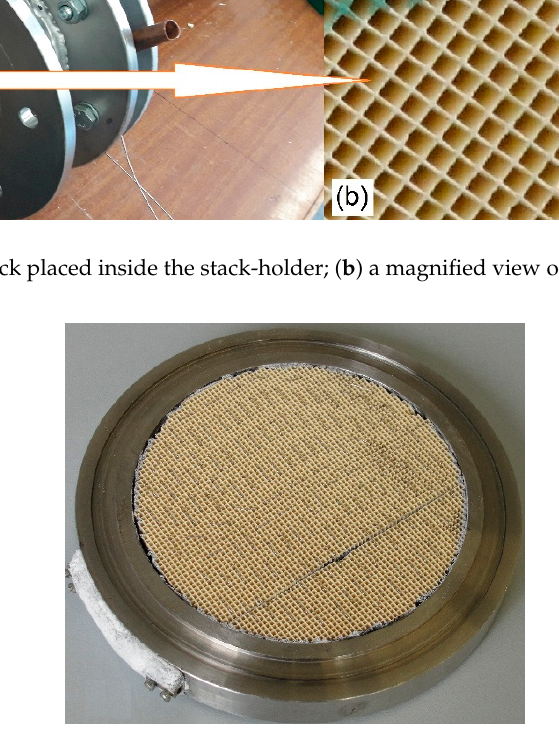
Figure 3. The heater.